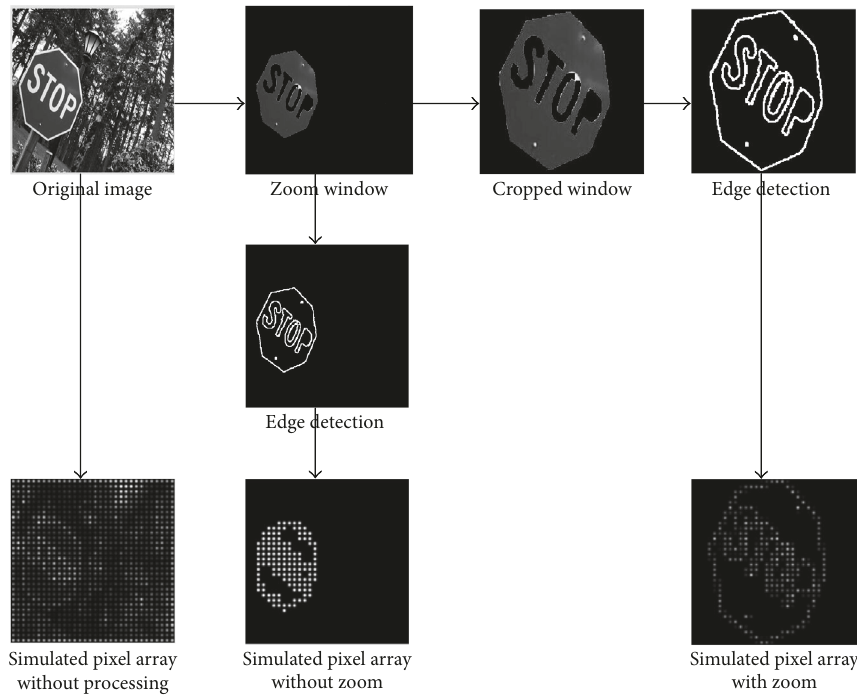
Figure 4: Flowchart of the FZE processing strategy.